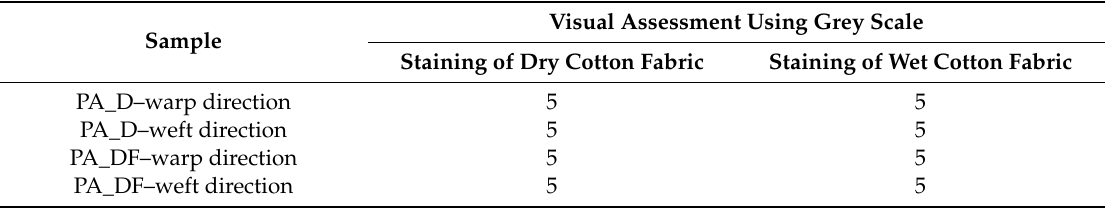
Table 2. Visual assessment of colour fastness of tested samples to dry and wet rubbing.